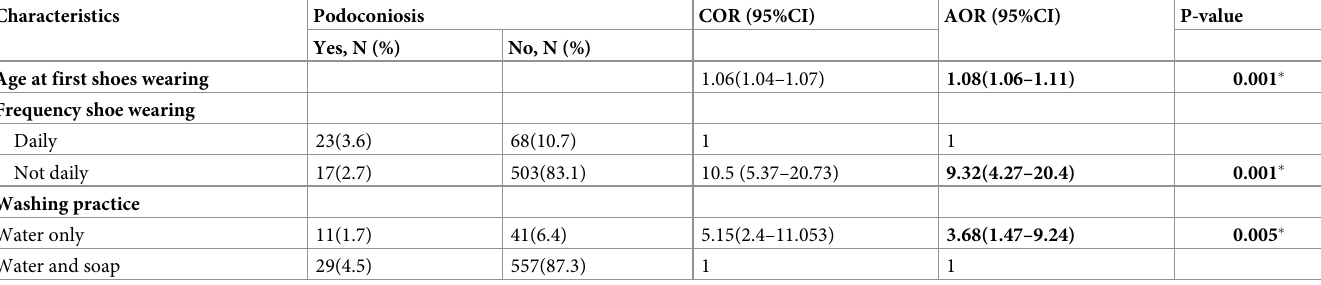
Table 3. Factors associated with podoconiosis in Dano district, 2018.